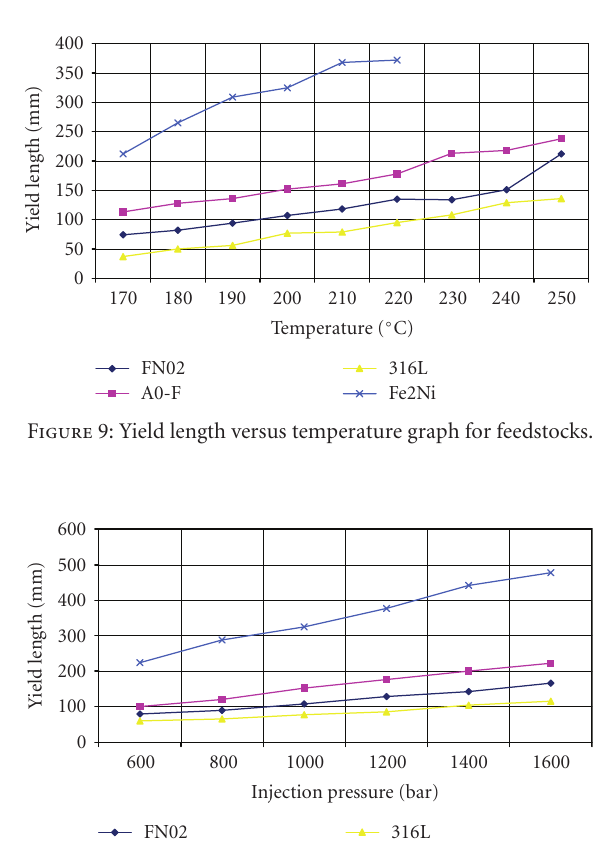
pressure and temperature were kept as 1000 bar and 200 ◦ C,